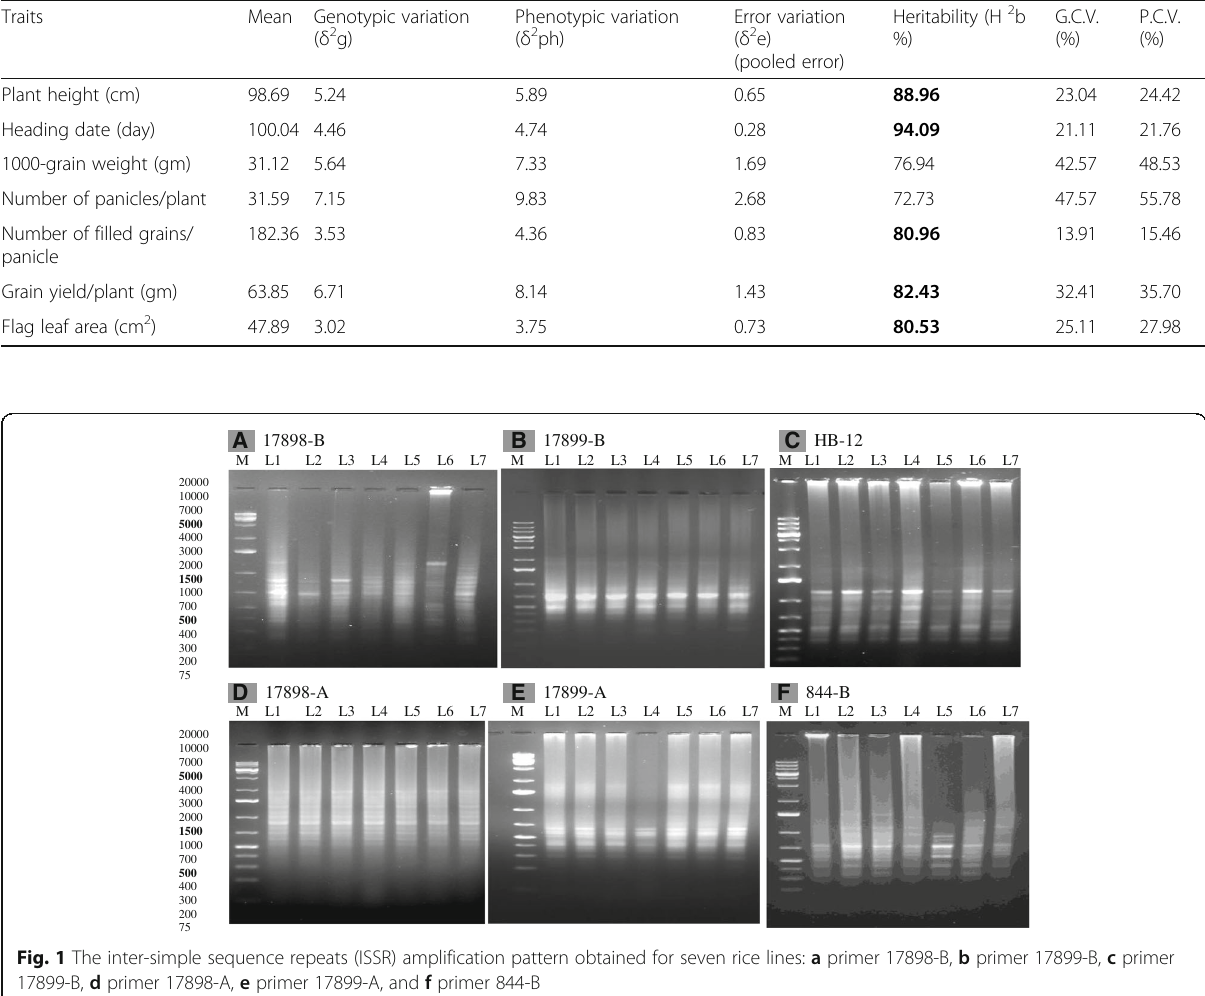
Table 15 Genotypic ( δ 2g), phenotypic ( δ 2ph), error variances ( δ 2e), heritability (H 2 ) in the broad sense: genotypic (G.C.V.) and phenotypic (P.C.V.) coefficients of variation evaluated for seven traits of rice lines